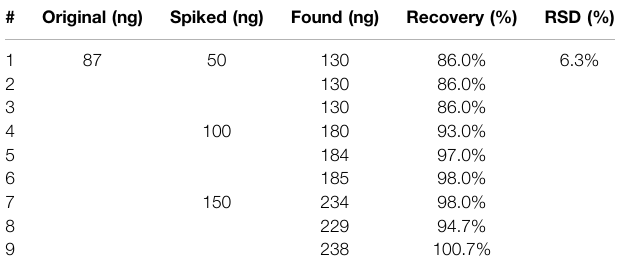
TABLE2 | Recovery test of the established LC-MS/MS-MRM